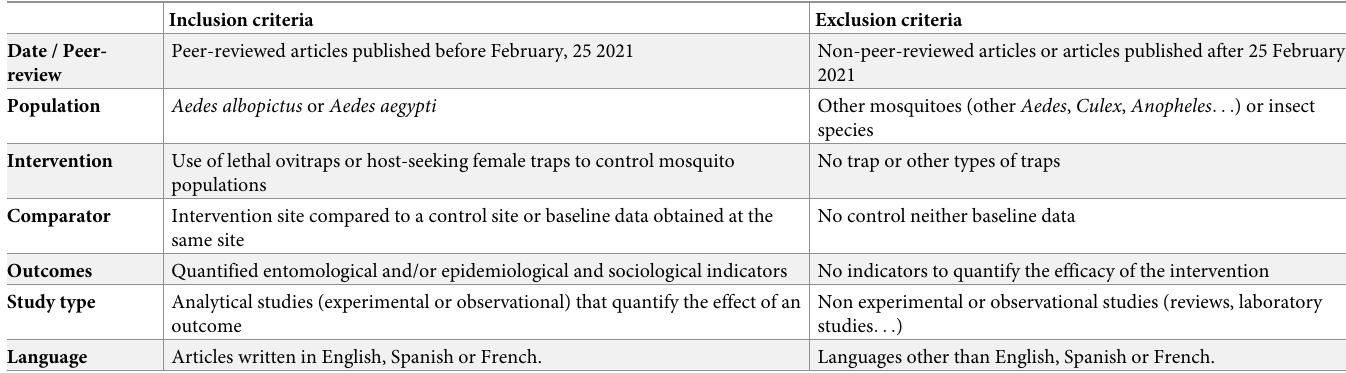
Table 2. Inclusion and exclusion